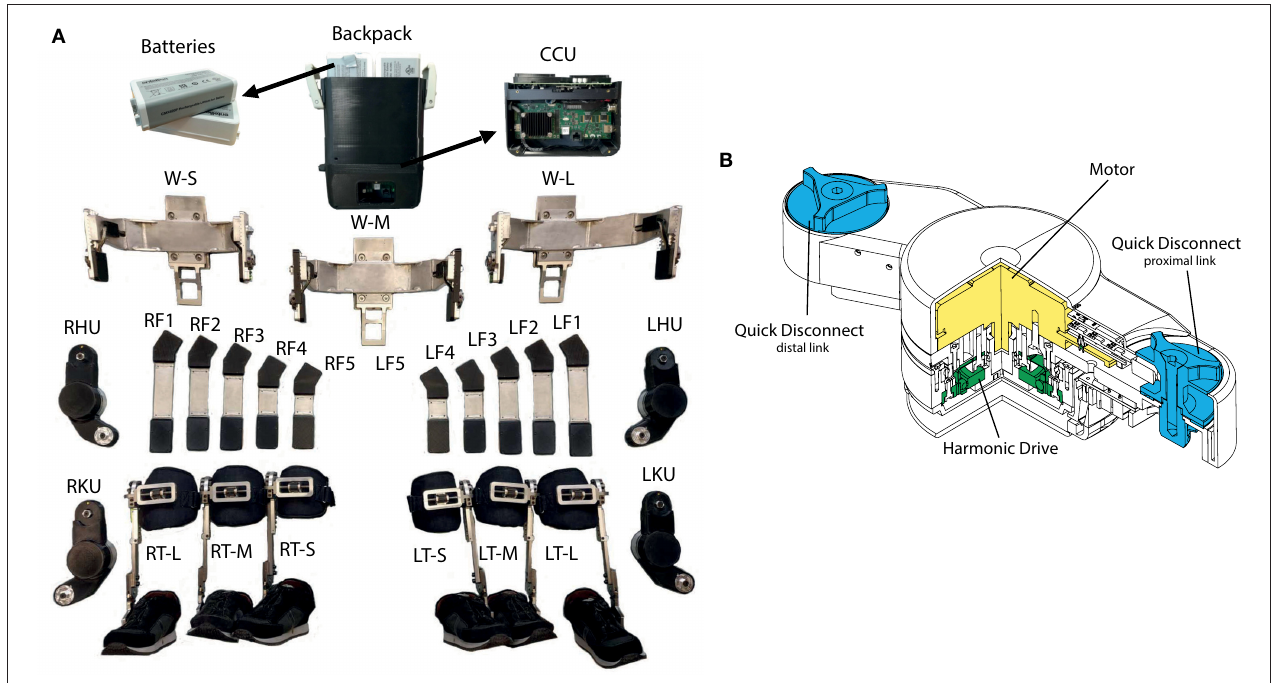
FIGURE 7 | (A) The main structural parts of TWIN. From the top, batteries, and backpack, Central Control Unit (CCU); W-S, W-M, and W-L are three waists sizes (small, medium, large); RHU/LHU are right and left hip motor unit; RF1,…, RF5 and LF1,…, LF5 are right and left femur sizes; RKU/LKU are right and left knee motor unit; RT-S, RT-M, RT-L, LT-S, LT-M, LT-L are right and left tibia sizes; AFOs are located inside the shoes, ranging from 38 to 46 EU shoe size. (B) The actuation module used for actuating the exoskeleton. A Maxon EC90 flat motor is coupled to a 100:1 CSD Harmonic Drive gear. Two quick disconnect systems are located at both proximal and distal link